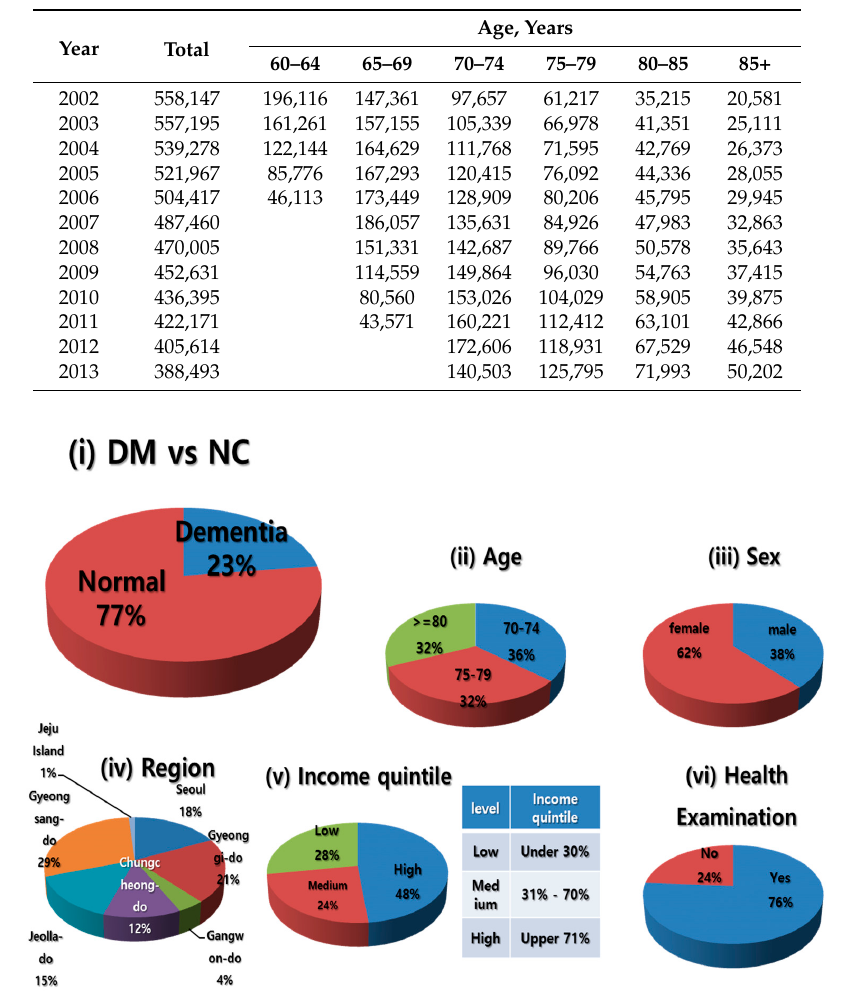
Figure 3. Distribution of the Korea National Health Insurance Service Senior Cohort (KNHIS-SC) database, as of 2013. DM, dementia group; NC, normal